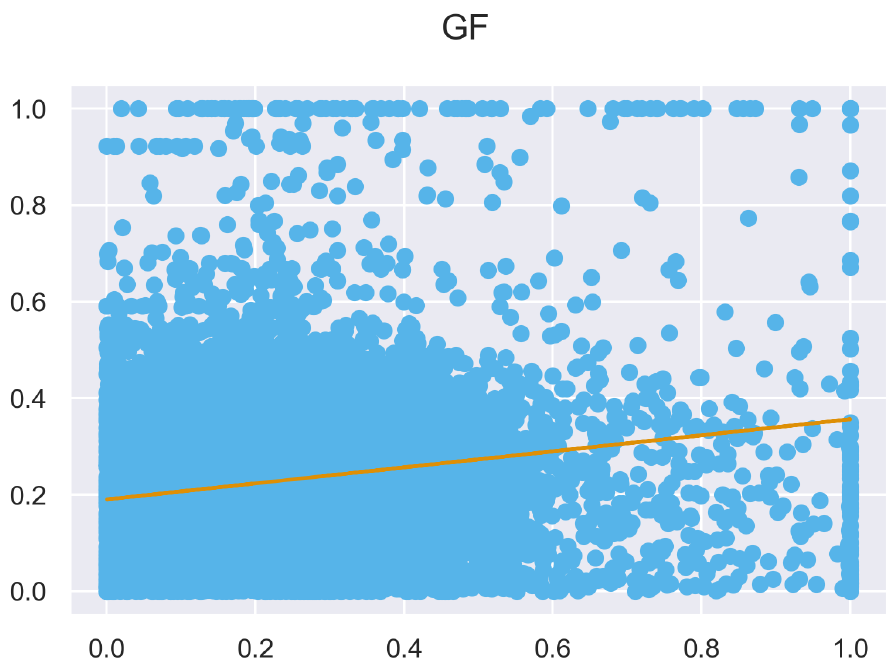
Figure A10. ULS and TLS GF regression at 0.5 m grid